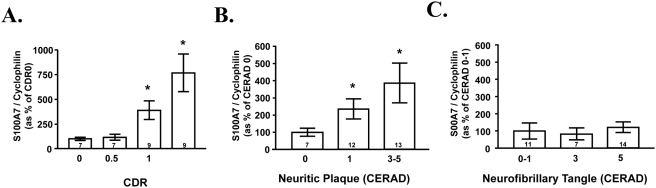
S100A7 mRNA expression in AD brain increases as a function AD dementia and amyloid neuropathology.
A, S100A7 content in BM 8 (quantified by real-time RT-PCR and normalized by cyclophilin) as a function of CDR representing cognitive normalcy (CDR 0), questionable dementia (CDR 0.5), mild dementia (CDR 1), and severe dementia (CDR 5). Data are expressed as mean±SEM and are shown as percent of CDR 0 group. B, C, S100A7 mRNA expression as a function of β-amyloid NP plaque and NFTs neuropathology, respectively, in accordance with the CERAD four-point scale for AD. Data represent mean±SEM and are shown as percent relative to CERAD 0 group, respectively; in A–C statistics were calculated by two-way ANOVA followed by Dunnett's t-test vs. control; *P<0.05. The number inside each bar indicates number of cases analyzed.